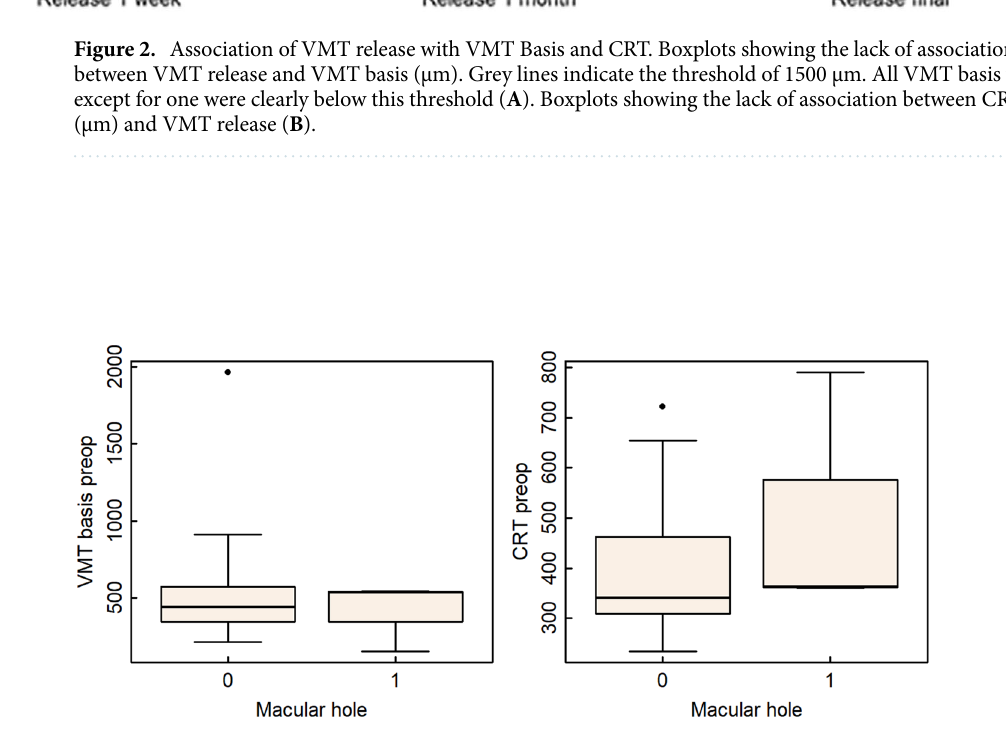
Figure 3. Complications in relation to VMT basis and CRT. Medians (ranges) of VMT basis (µm) and CRT (µm) for the three patients who developed a macular hole and the 26 others. There were no significant